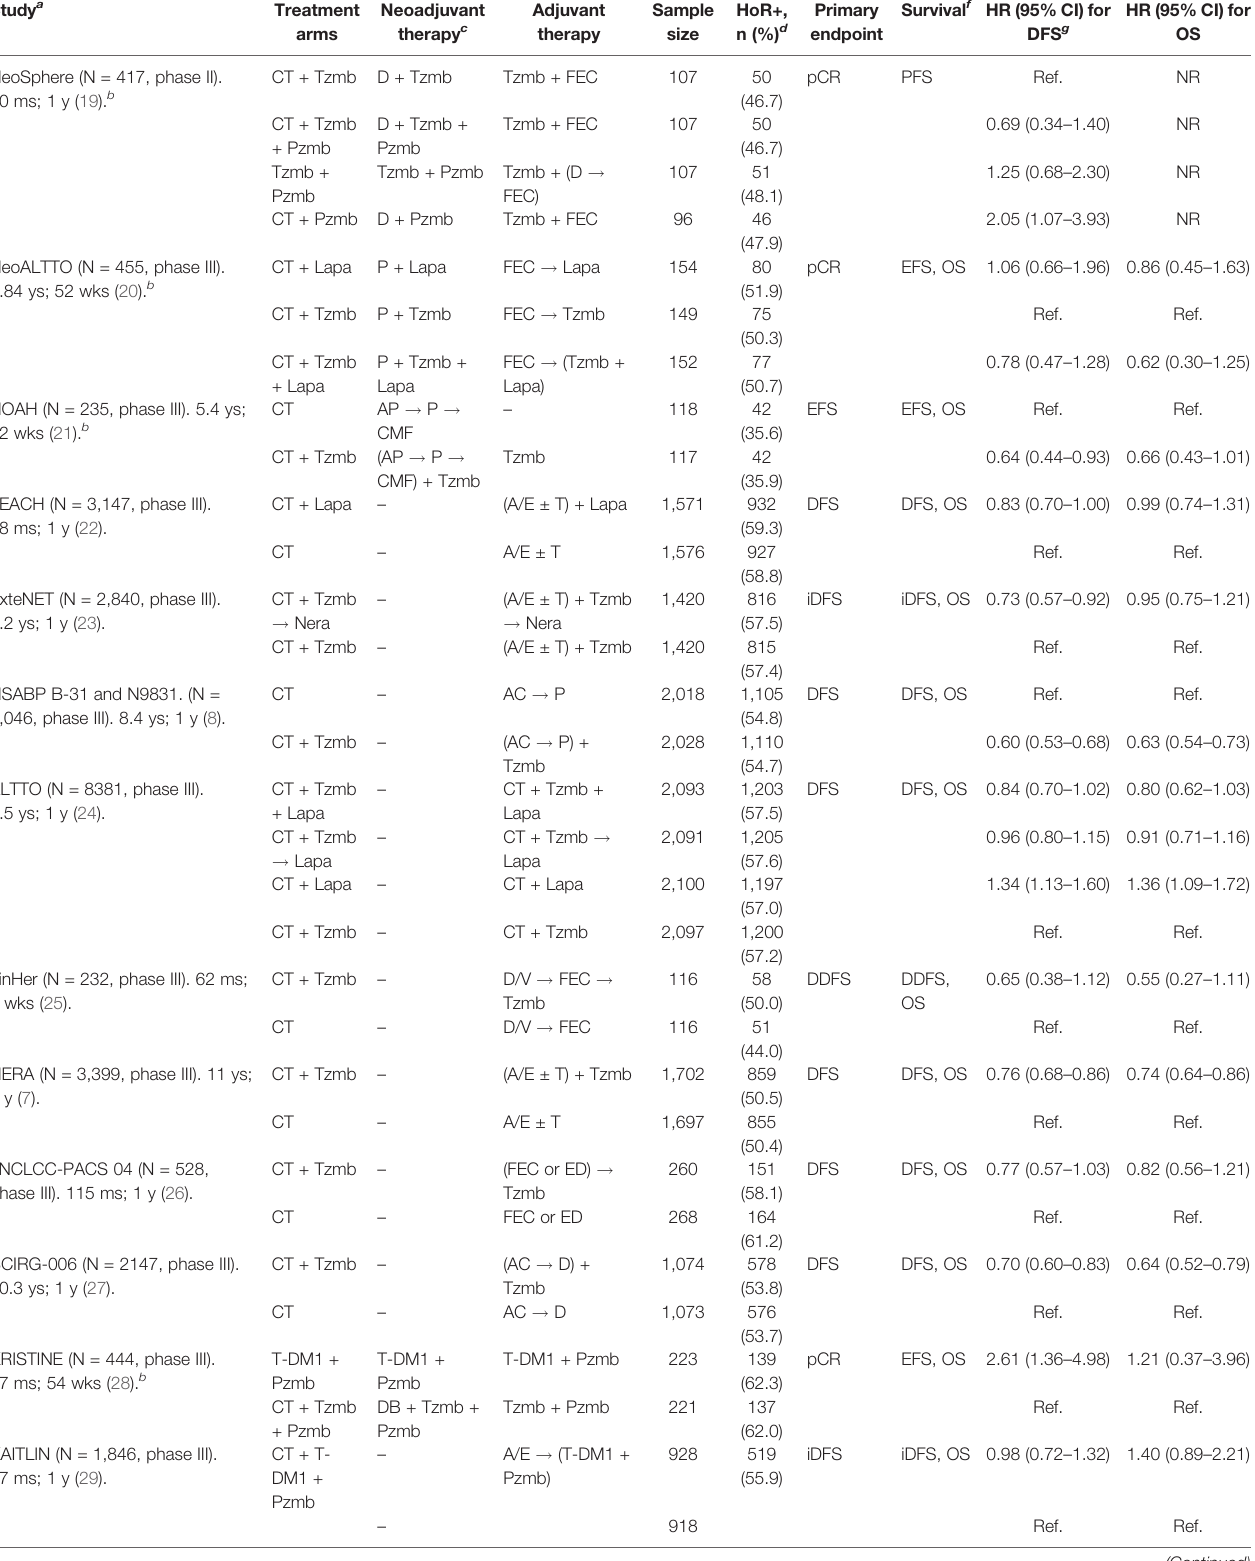
TABLE 1 | Baseline characteristic of enrolled